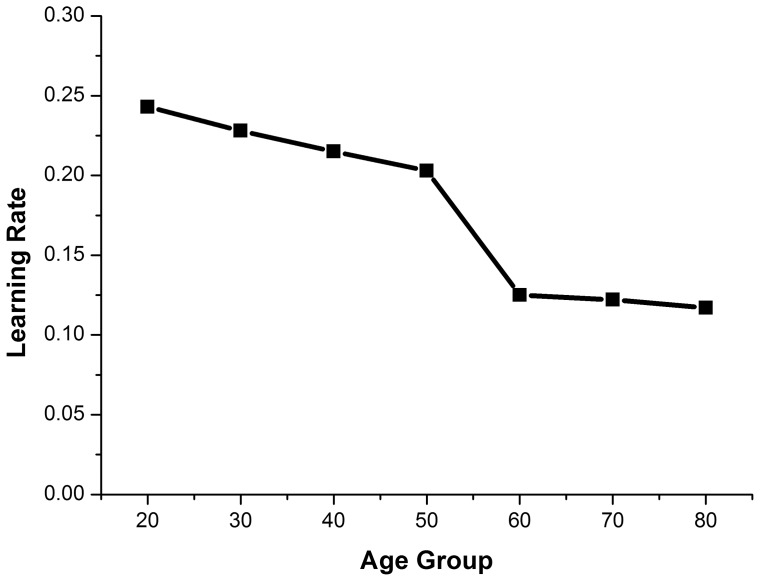
Learning rates for all age groups.Note the dramatic drop from 50